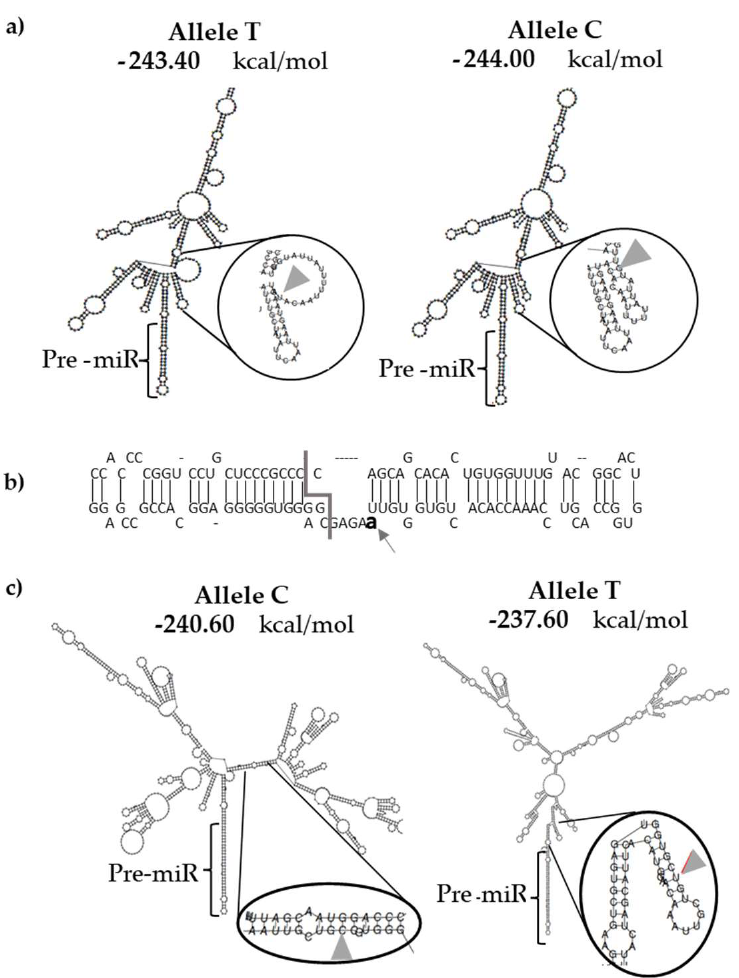
Figure 1. Secondary structure modeling of pri-miRNAs and their genetic variants. ( a ) Structure of pri-miR-335 with the T and C alleles using the RNAfold program. The variant is located at 13 bp of the pre-miRNA. The grey arrowheads indicate the position of rs376491654. ( b ) A schematic of the pre-miR-497 obtained from miRBase is observed, in which the mature 5′ strand and 3′ transient strand are shown. The rs755634302 variant corresponds to an adenine insertion (grey arrow), which is located 3 bp from the Drosha cleavage site (grey line). ( c ) Structure of pri-miR-155 with alleles C and T using the RNAfold program. The rs190708267variant is located 43 bp of the flanking region of the 3′ end of the pre-miRNA-155 and its position is indicated with grey arrowheads.